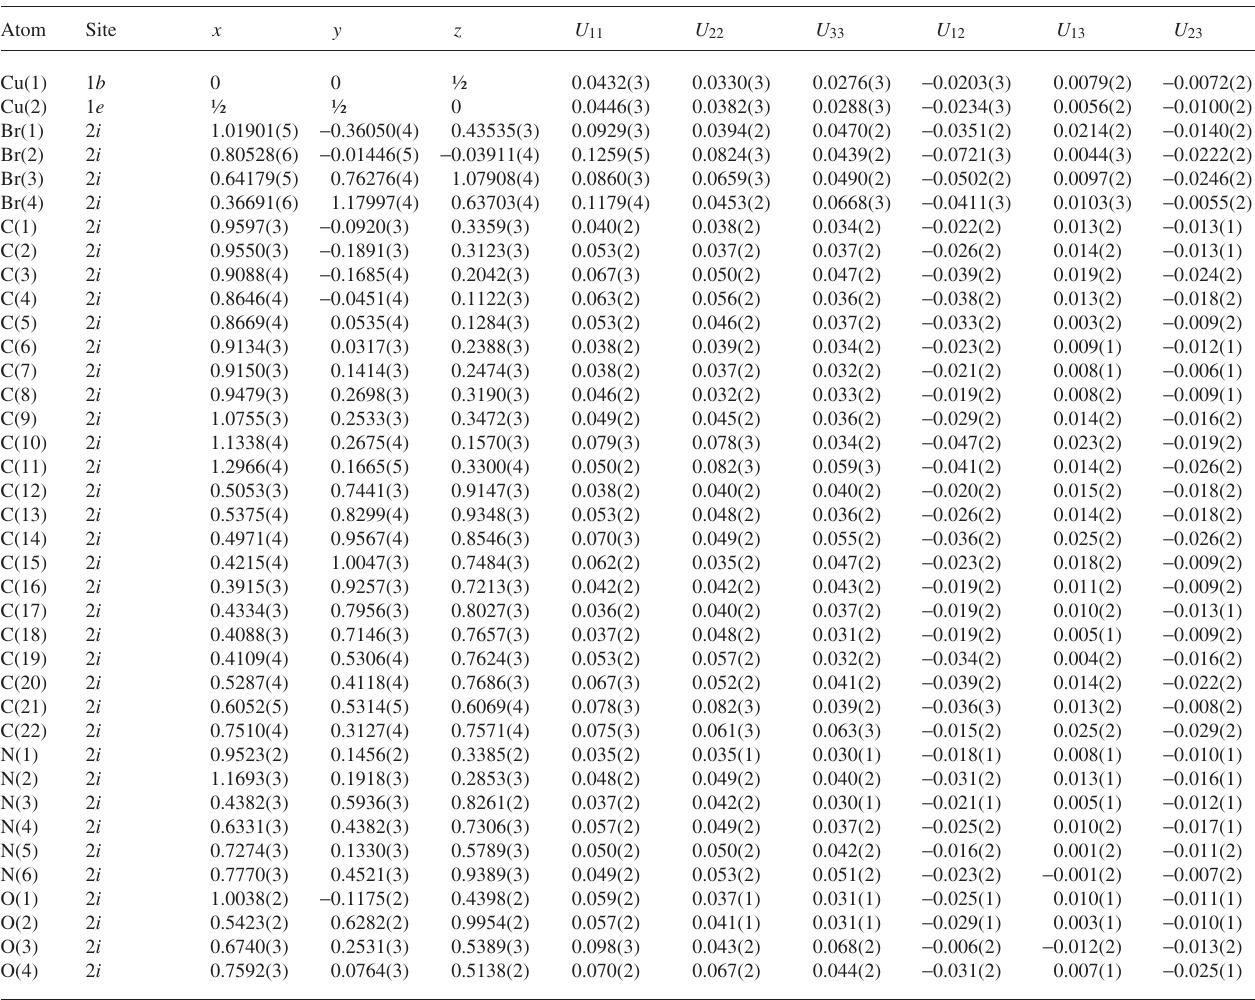
Table 3. Atomic coordinates and displacement parameters (in Å 2 ) .